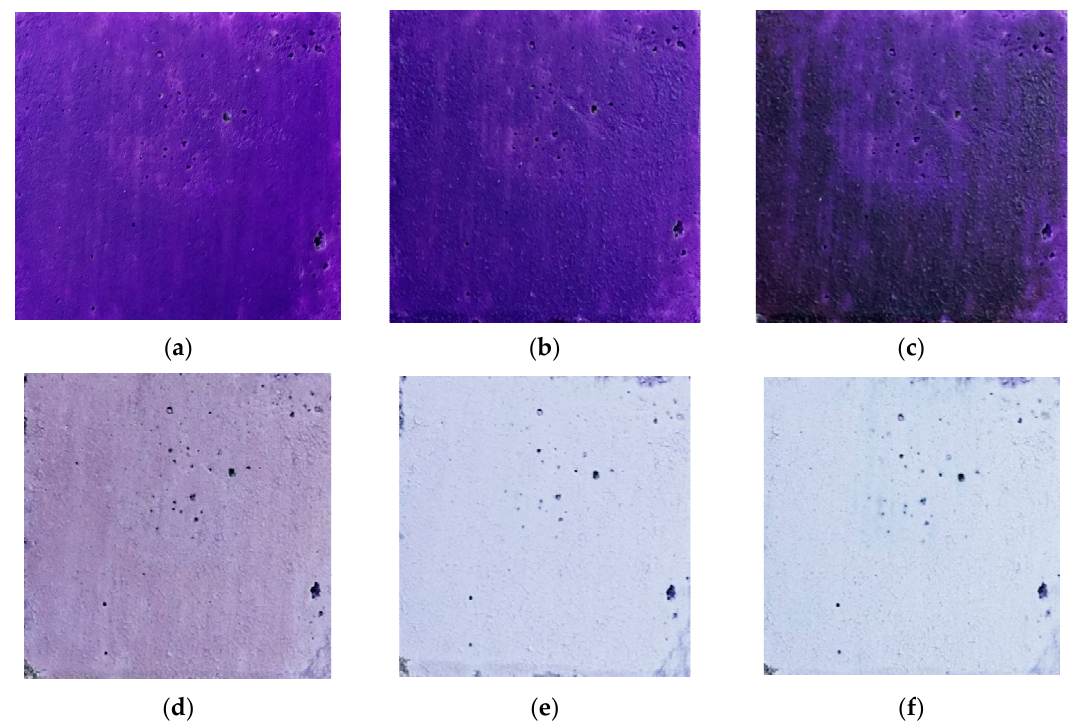
Figure 6. Color change process of MnNH 4 P 2 O 7 coating obtained at ( a ) ambient temperature; ( b ) 100 °C; ( c ) 200 °C; ( d ) 300 °C; ( e ) 400 °C; ( f ) 450 °C.